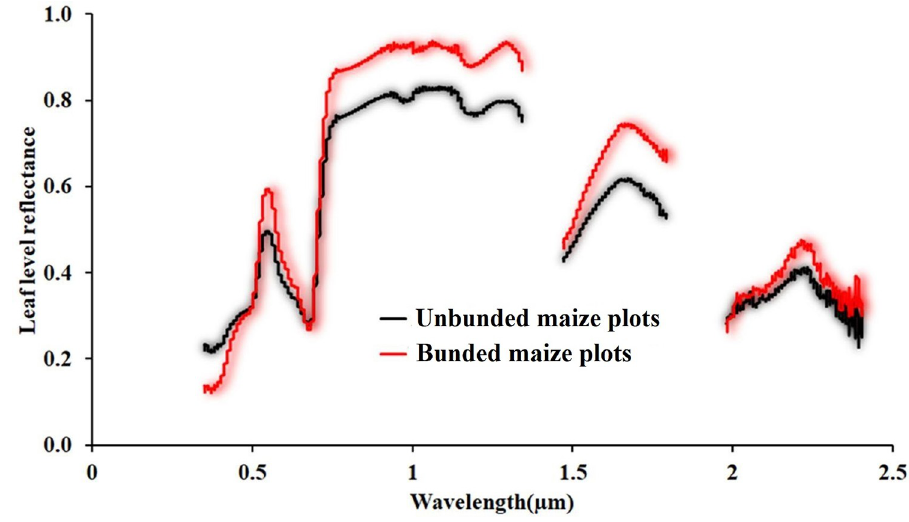
Fig 4. Spectral reflectance response of maize leaves in Aba Gerima catchment.